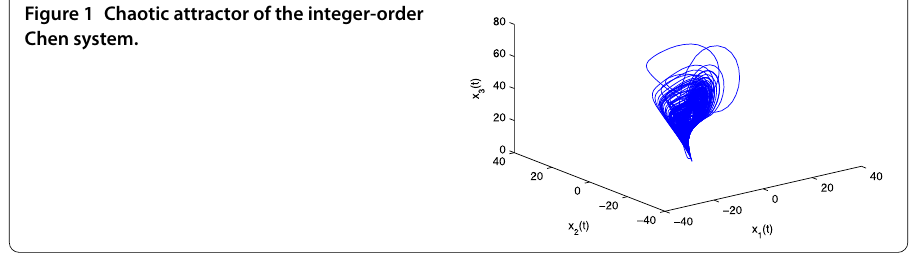
Figure 2 Attractors of the fractional-order hyper-chaotic Chen